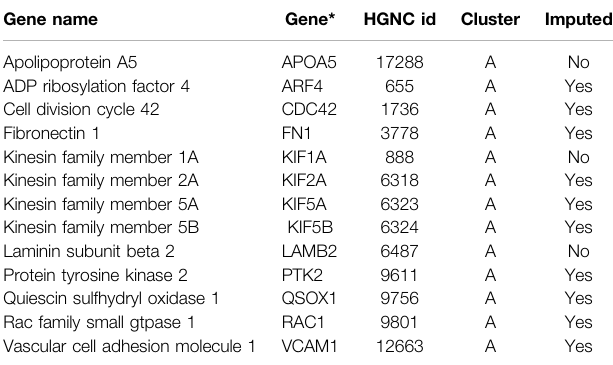
TABLE 3 | Unique genes from case dominated cluster (Cluster A). *Genes alphabetically